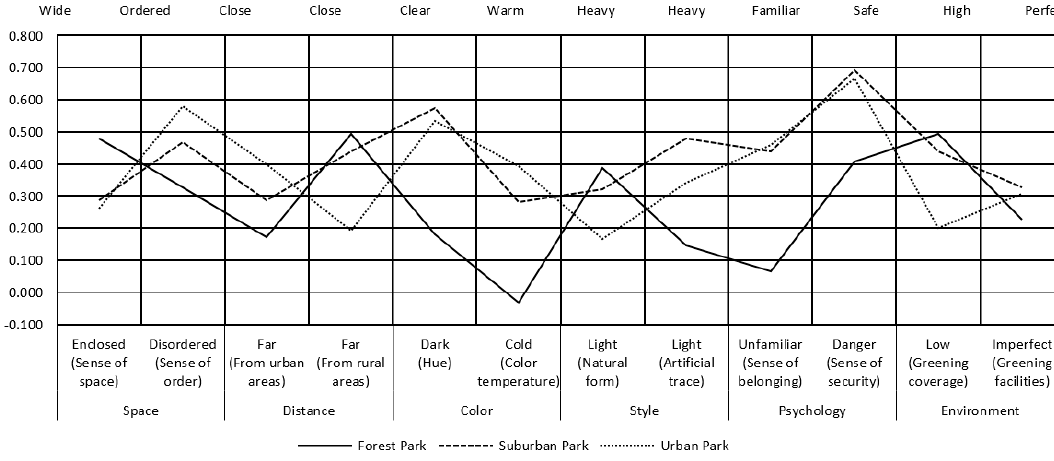
Figure 2. Research area of this study. Figure 2. The SD evaluation curve of this